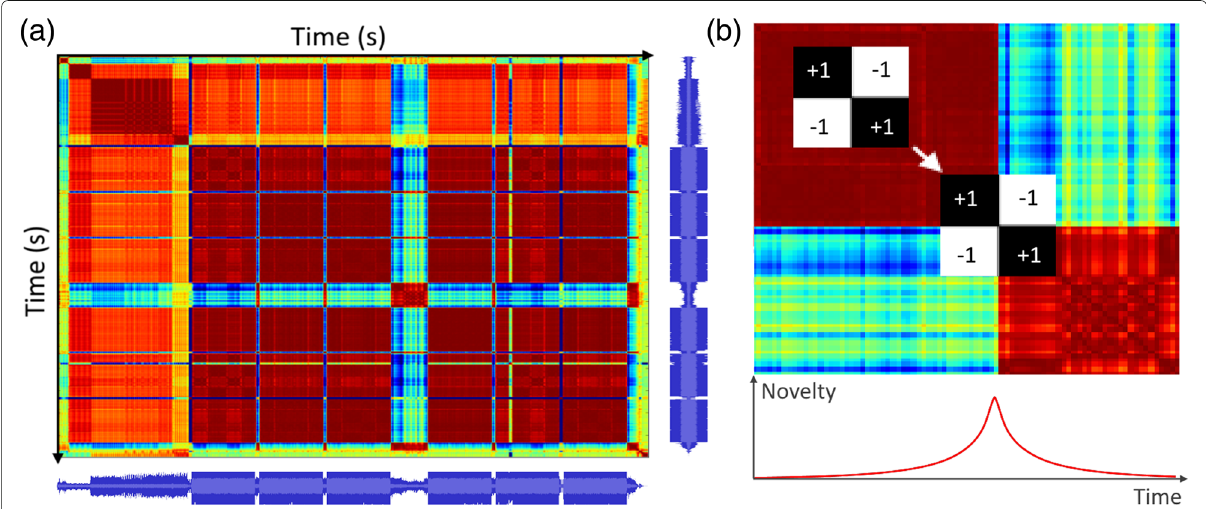
Fig. 6 Illustration of structural segmentation concepts. a Example of a structural similarity matrix. The audio waveform is shown next to both axes. b Calculation of the novelty curve by convolving the SSM with a checkerboard kernel along the